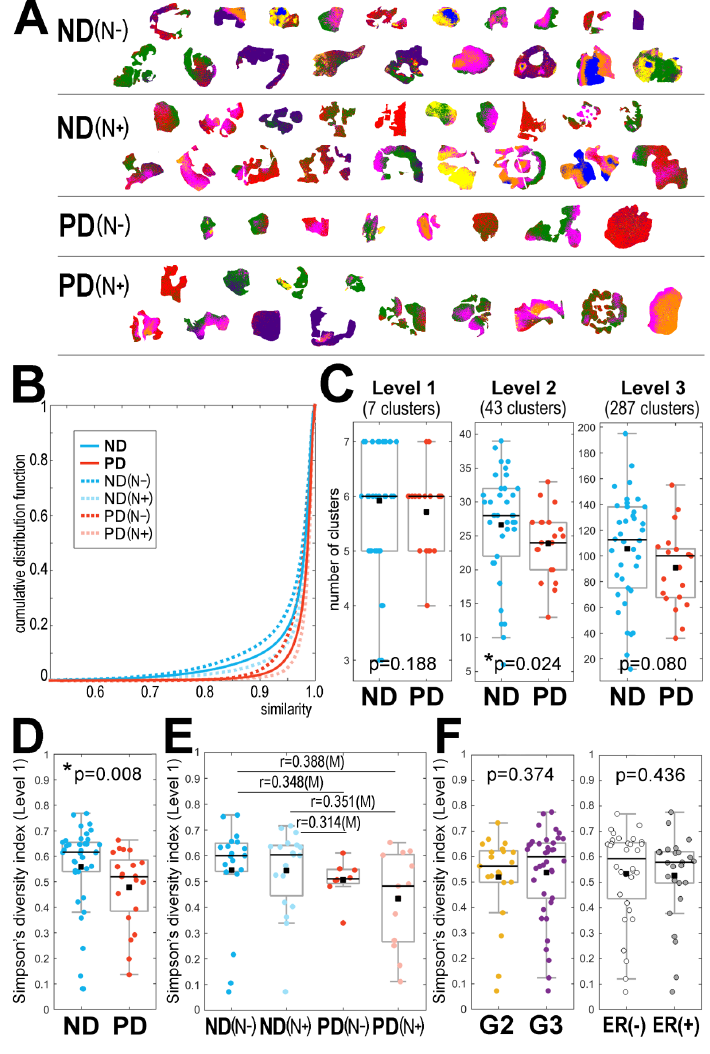
Figure 1. Heterogeneity of cancer ROI revealed by MALDI-MSI in breast cancer. Panel ( A )—the distribution of 7 clusters (artificially color-coded) defined at the first level of unsupervised segmenta- tion of cancer ROIs from 59 tissue specimens analyzed together; patient groups: ND—no evidence of disease, PD—progressive disease, cancer-free and cancer-containing lymph nodes marked with (N − ) and (N+), respectively. Panel ( B )—the cumulative distribution function of the spectra similarity index analyzed within each cancer ROI. Panel ( C )—the number of clusters generated at the first three levels of image segmentation in samples from the ND and PD groups. Simpson’s diversity index computed for the first level of image segmentation in samples from the ND and PD groups (Panel ( D )), samples from the patients’ subgroups with different lymph node status (Panel ( E )), and samples of cancer with different pathological grades (G2 vs. G3) and expression of estrogen receptors (Panel ( F )). Boxplots represent minimum, maximum, lower and upper quartile, and median. The p -value of differences between two groups (panels ( C , D , F )) and [r] effect size for multiple pairwise comparisons of four groups is shown (panel ( E ); differences with at least a medium effect size are shown). * p < 0.05 is marked with